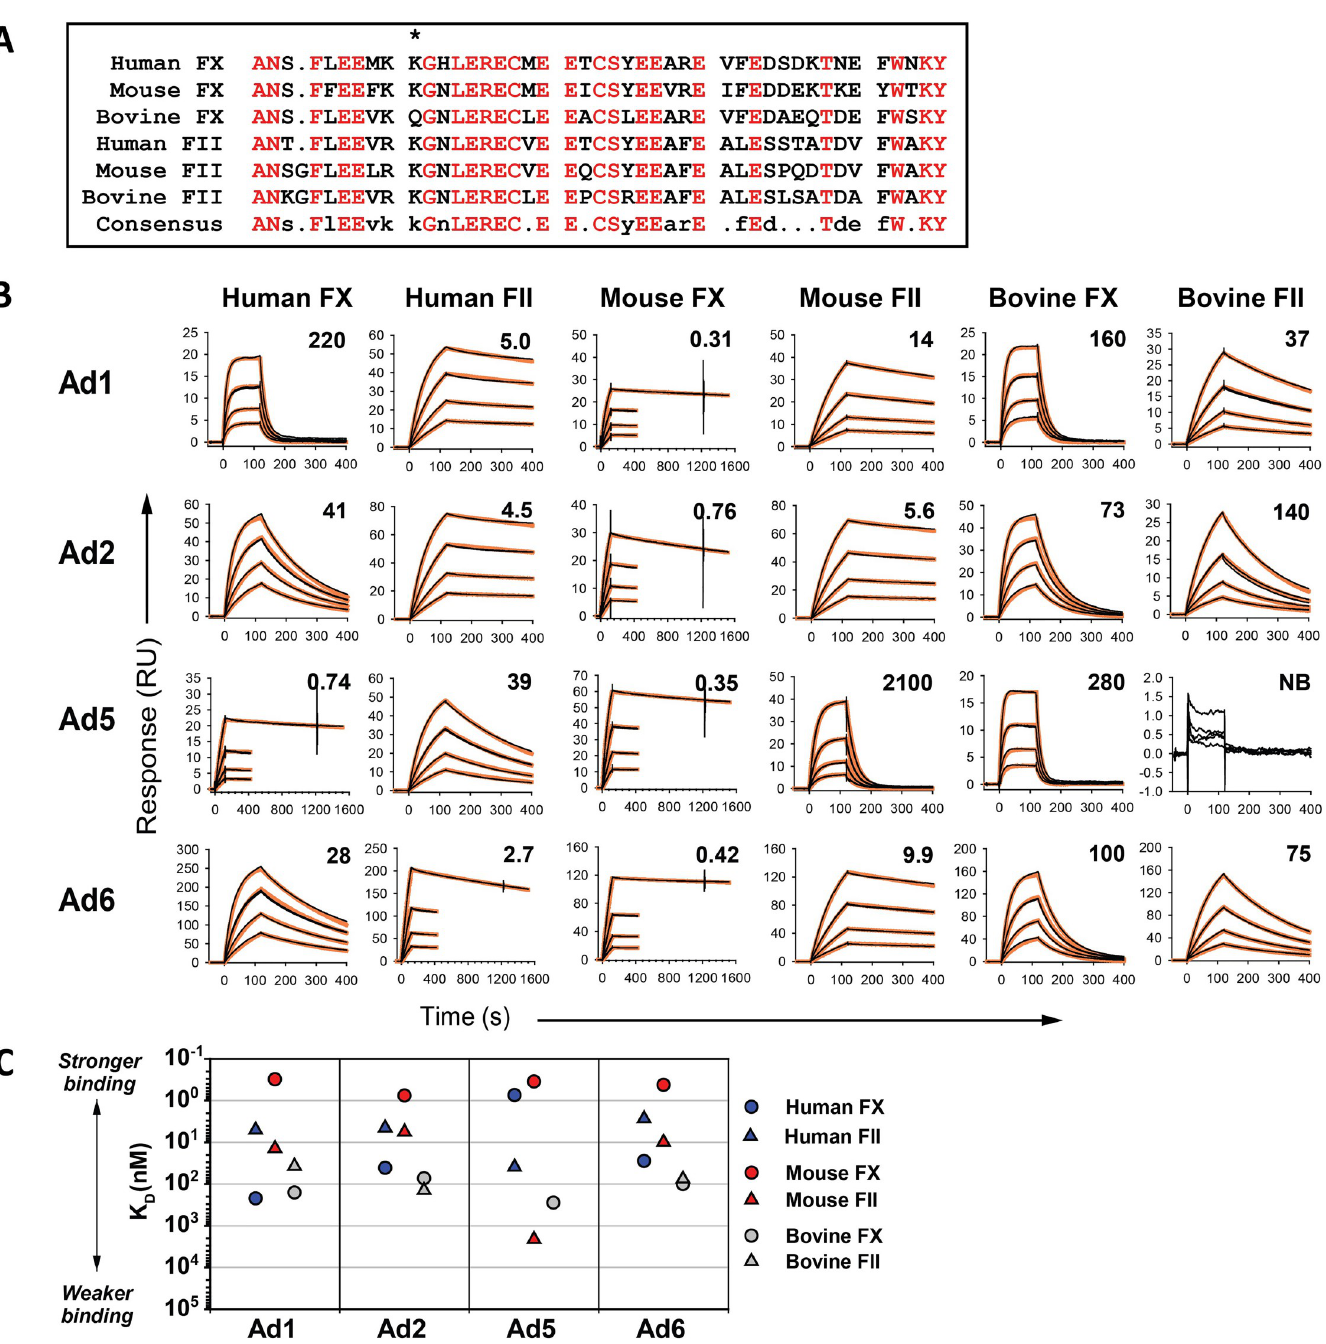
Fig 4. Binding of FX and FII to wild-type species C Ads. (A) Comparison of the Gla domain sequences of FX and FII. � indicates K10 of human FX, which has been proposed to interact directly with the FX binding site on Ad5 hexon [11]. (B) Wild-type adenoviruses were immobilized, and the binding of human, mouse and bovine FX and FII were evaluated using SPR. Experimental data are shown in black, and fitted curves are shown in orange. Kinetic binding affinities (K D ) are indicated in nM on each graph, and were calculated using global fitting to a 1:1 interaction model. NB: No binding. (C) Graphical display of binding affinities from the SPR experiments in panel